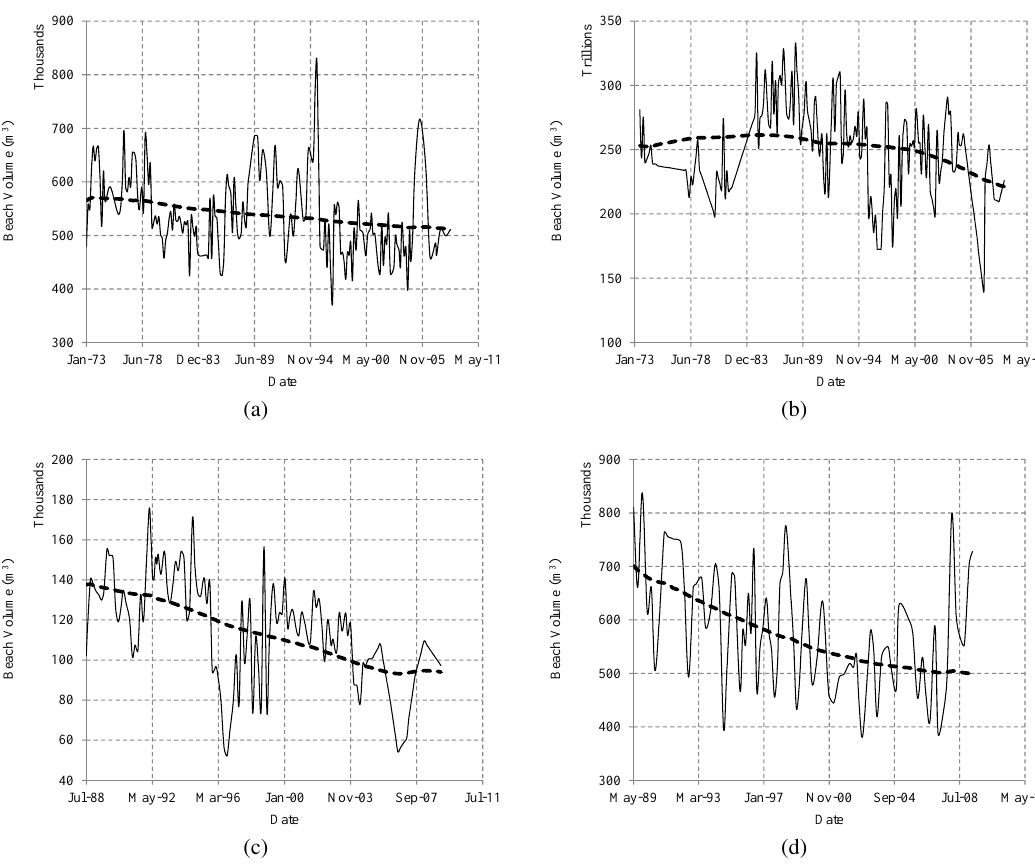
Fig. 4. Singular spectrum analysis of beach volume blocks showing the original time series by the solid line and the reconstructed time series shown by the dashed line. Each data point represents a 3 month interval. (a) Block volume B–F, (b) Block volume 1–18, (c) Block volume 19–23, (d) Block volume BR6–BR9 (refer to Fig. 3).